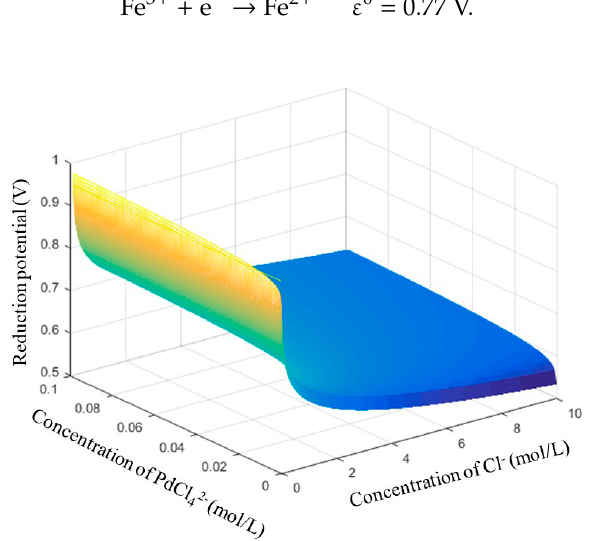
Figure 2. Equilibrium potentials for semi-reaction of Pd reduction in chloride media.